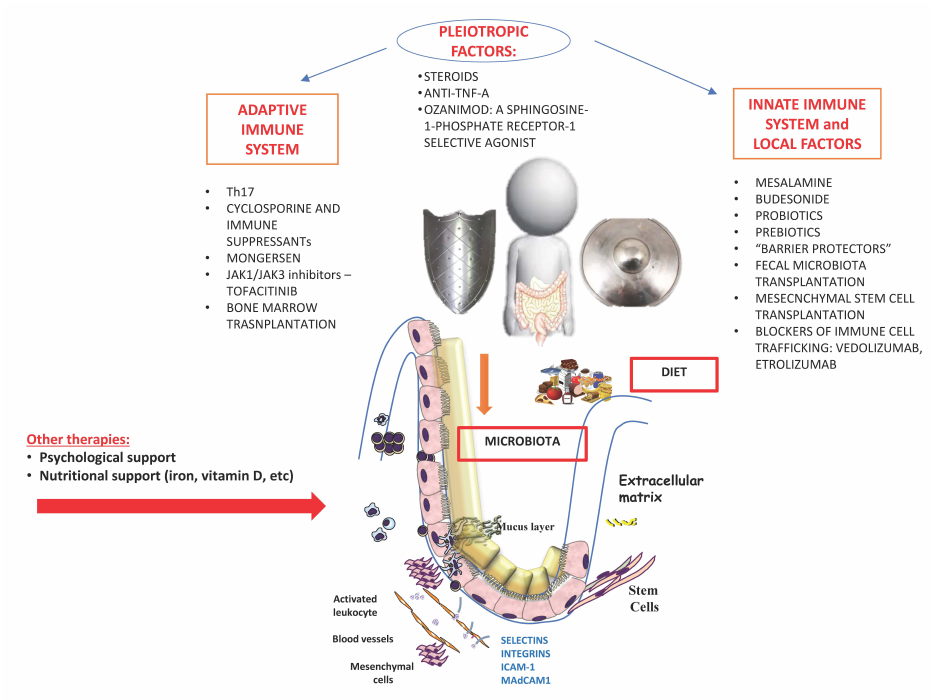
Figure 2. New drugs in IBD (inflammatory bowel disease) targeting innate and adaptive immune system.